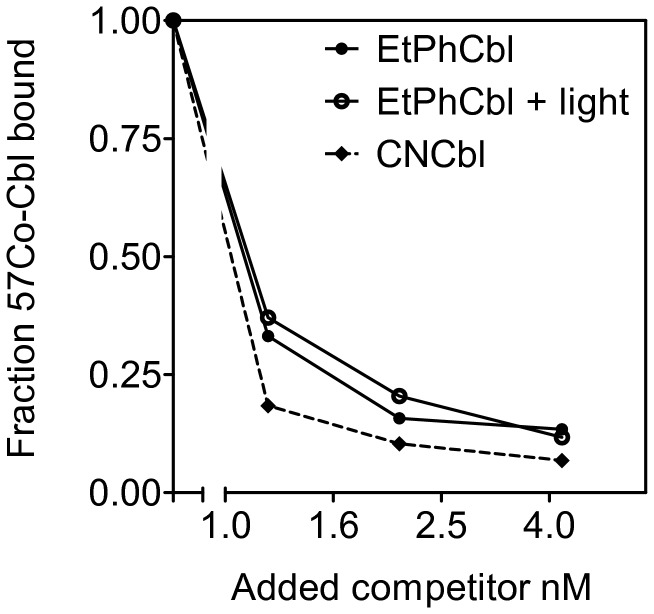
Binding of Coβ-4-ethylphenyl-cob(III) alamin (EtPhCbl) to mouse TC.Increasing concentration of EtPhCbl (with and without exposure to light) or vitamin B12 (CNCbl) was incubated with57[Co]-Cbl and mouse TC. The quantity of bound57[Co]-Cbl was expressed relative to the amount bound when only57[Co]-Cbl was present. A logarithmic scale was used on the X axis.